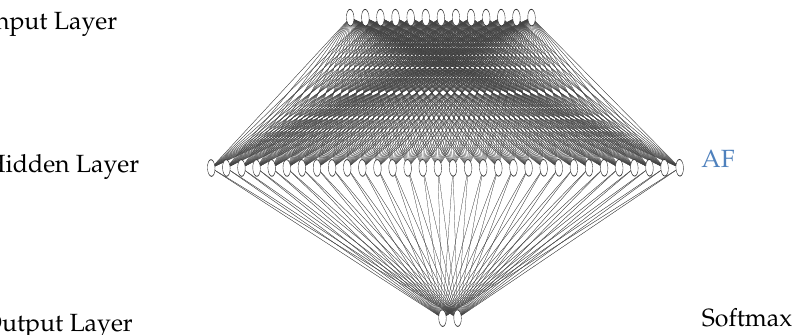
Figure 1. Schematic of the MicroNets used in this project to evaluate the hardware. Structure of the NNs is 13–32–2. The NNs differ in their activation function (AF) in the hidden layer, therefore marked in